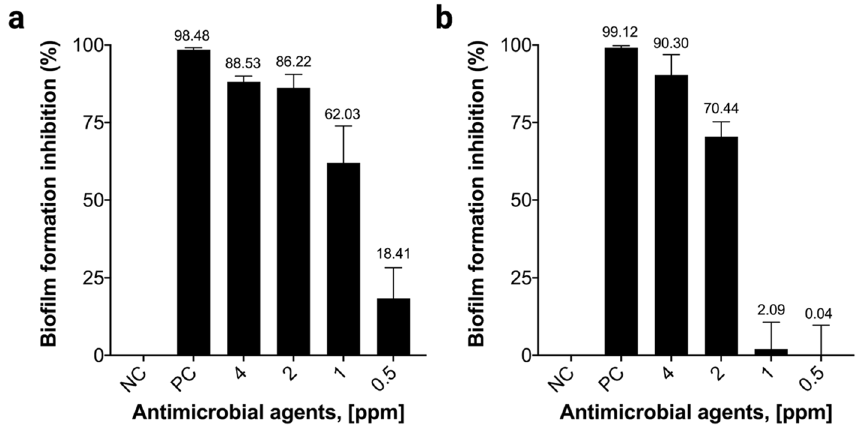
Figure 9. Antibiofilm activity of Bm -ponericin-L1 against ( a ) P. aeruginosa (ATCC 25668), and ( b ) K. pneumoniae (ATCC 70063). The data were expressed as mean ± standard deviation and the significance level was set at p < 0.05. NC: negative control. PC: positive control.